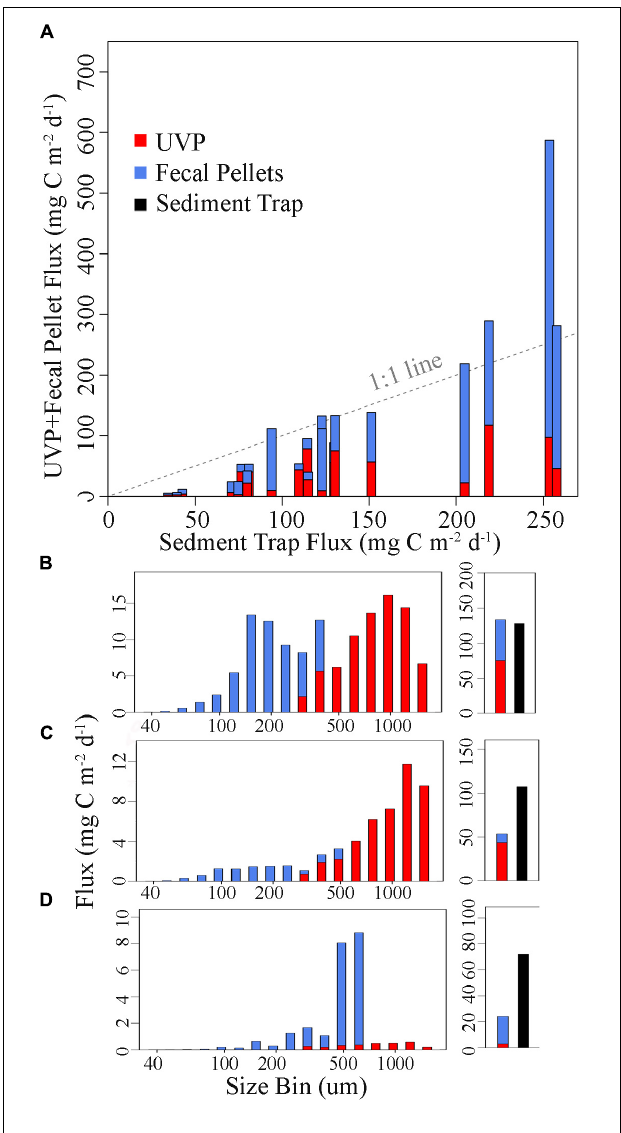
FIGURE 5 | Relative contribution of different particle sizes to flux if it is assumed that the Guidi et al. (2008) algorithm measures marine snow flux (red) and the experimentally measured recognizable fecal pellet flux (blue) is an additional flux term. (A) Cycle averaged UVP (Guidi) + fecal pellet flux estimates for CCEP0810 and CCEP1604, plotted against sediment trap flux. UVP (Guidi) + Fecal pellet flux as a function of particle size for (B) P0810-5 at 60 m, (C) P0810-6 at 100 m, and (D) P1604-2 at 100 m. (B–D) Subplot on the right shows the sum of UVP and fecal pellet flux (red and blue, respectively) compared to sediment trap flux (black).